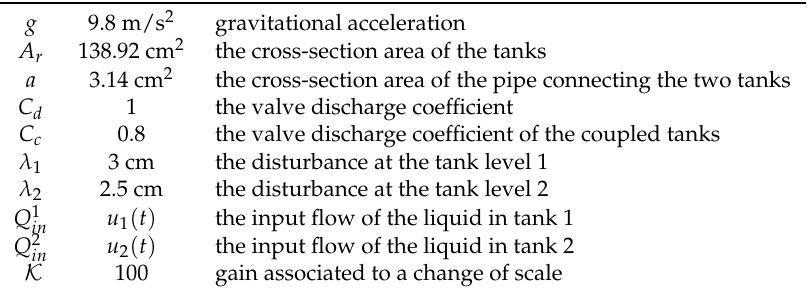
Table 3. Plant parameters used in the